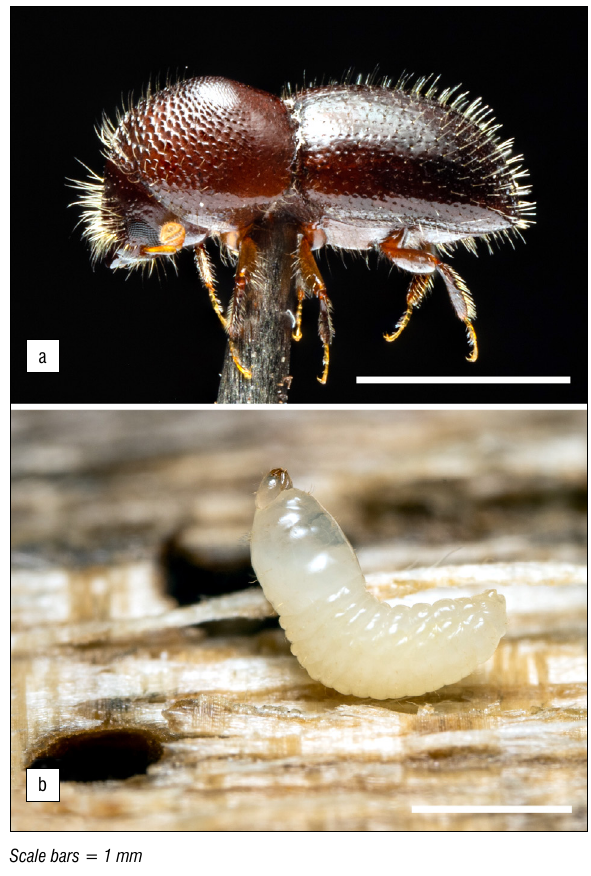
Figure 1: (a) Adult and (b) larva of the polyphagous shot hole borer beetle, Euwallacea fornicatus